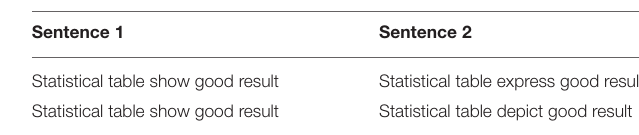
TABLE 3 | Example entries from the adjective-transitive dataset, cited from Grefenstette and Sadrzadeh [25].